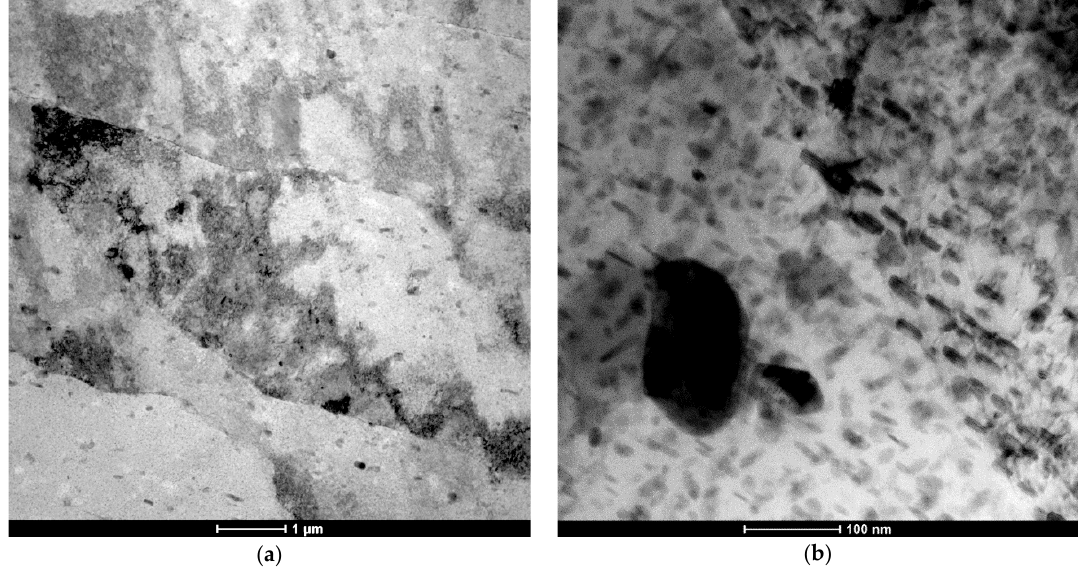
Figure 5. ( a ) Subgrains of α solution of the alloy with a high density of dislocations ; ( b ) An irregular precipitate inside the α solution subgrain.